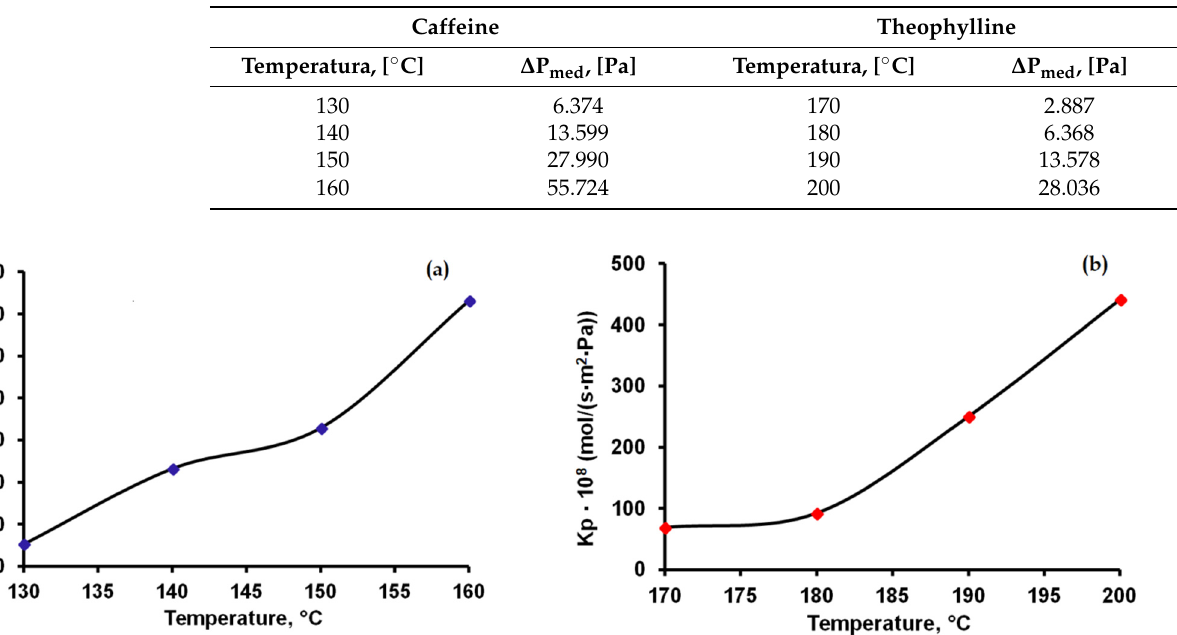
Figure 7. Influence of temperature on the mass transfer process for caffeine ( a ) and theophylline ( b ).